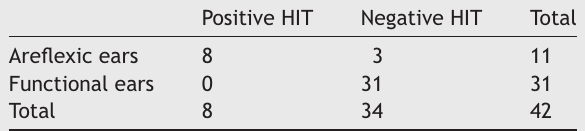
Table 4 Significance of a positive Head Impulse Test (HIT) and absence of function (areflexia) of the assessed ears (Fisher’s exact